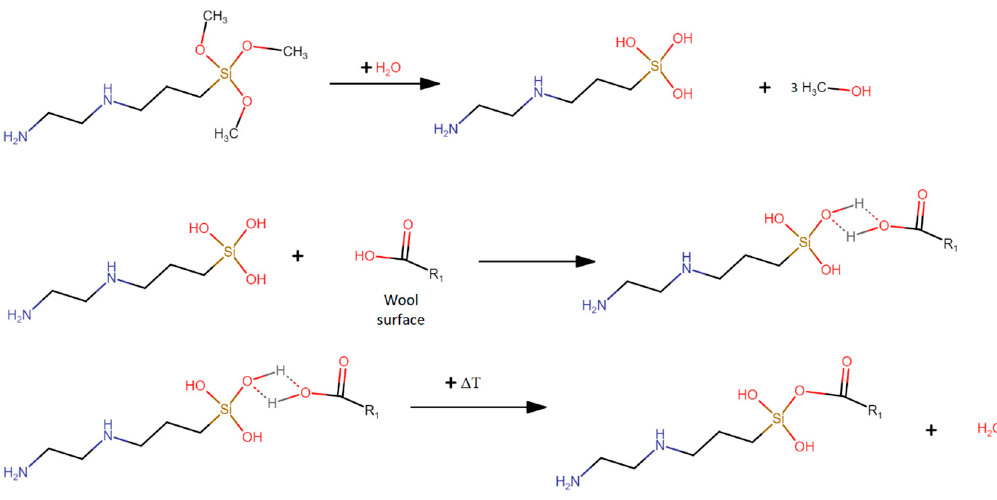
Figure 2. Scheme of coupling reaction of wool with coupling agent (3-(2-aminoethylamino)propyl)- trimethoxysilane.